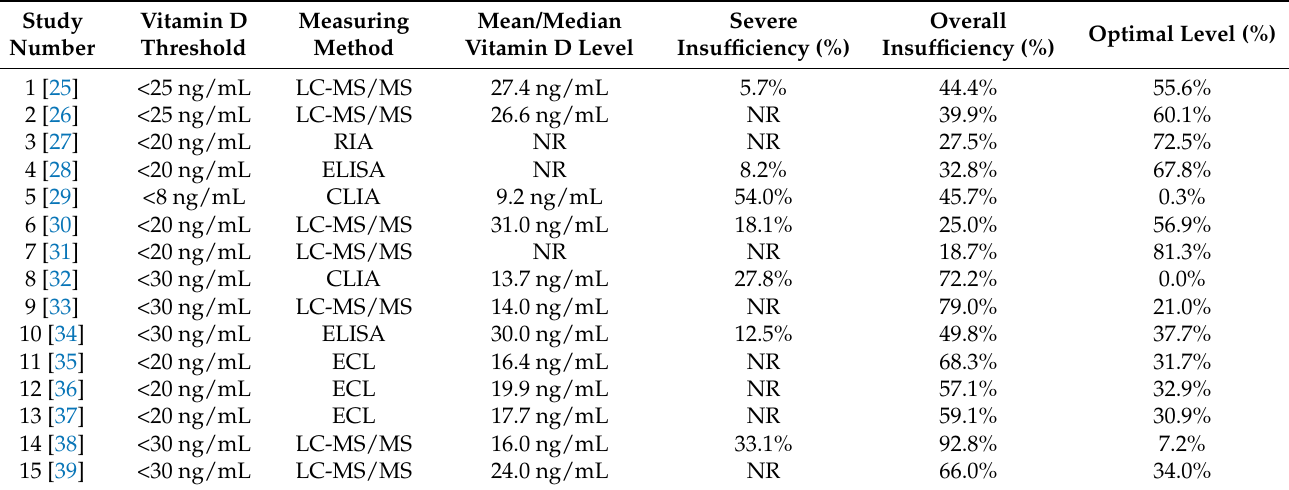
Table 3. Evaluation of vitamin D